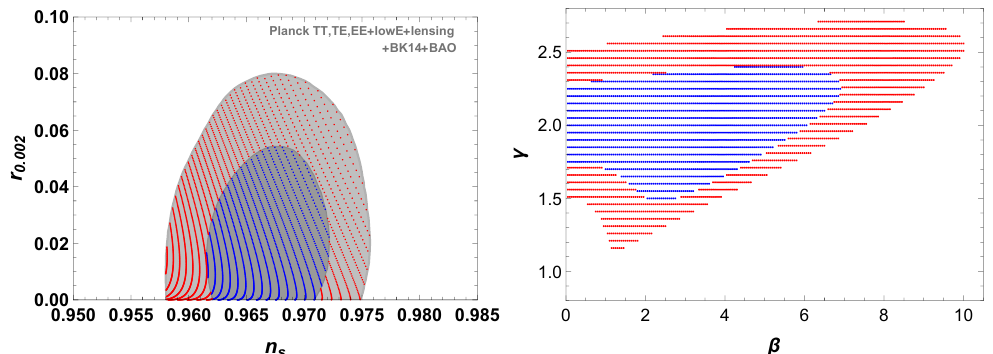
Figure 1. The constraints on n s and r 0.002 from Planck data [5] and the theoretical predictions for the parameterization (26) in the high friction limit. The Planck constraints on n s and r are displayed in the left panel and the constraints on β and γ for N = 60 are displayed in the right panel. The red and blue regions denote the 68% and 95% confidence level,